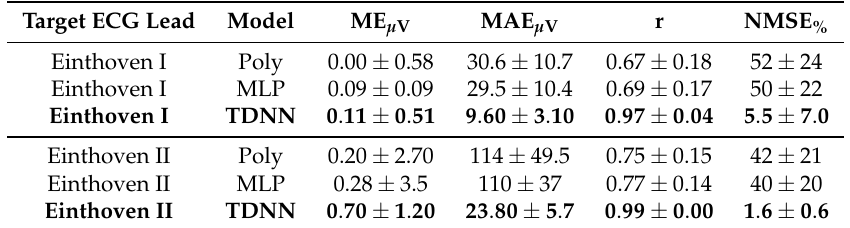
Table 2. Performances of the Einthoven I and II ECG lead estimations from the patch ECG for the optimal polynomial, MLP, and TDNN